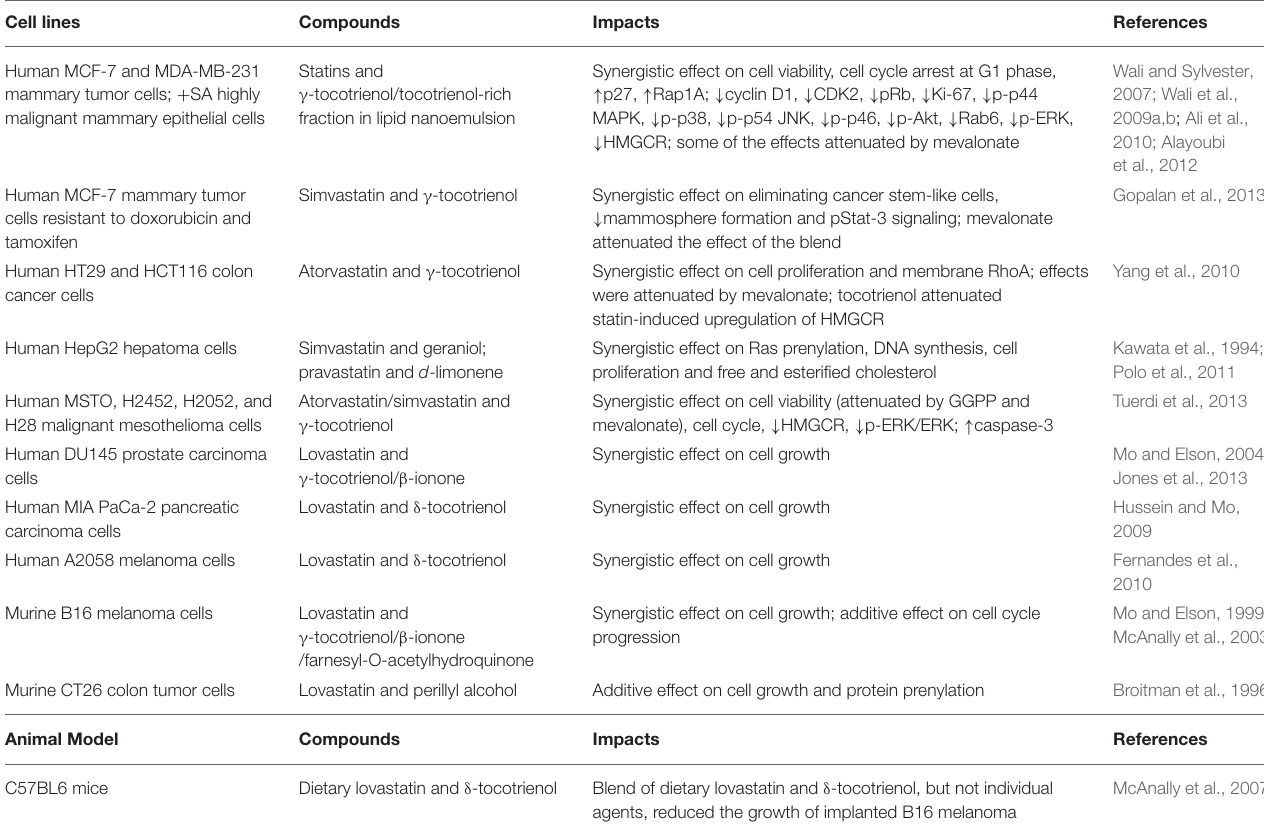
TABLE 3 | In vitro and in vivo studies showing that isoprenoids potentiate the tumor-suppressive effect of statins. Cell